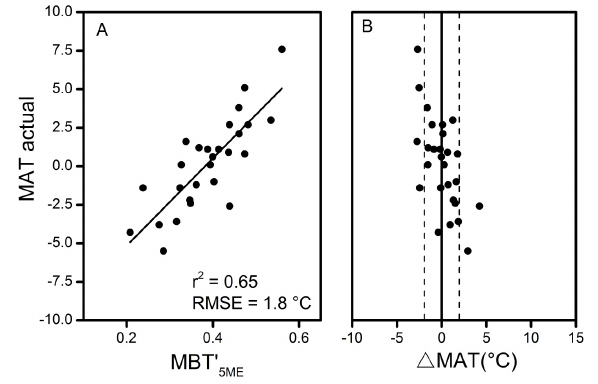
Figure 6. (a) Linear regression of MBT’ 5ME with actual MAT; (b) difference between estimated MAT and actual MAT ( (cid:49) MAT). Data in this study are from 27 surface soils of the QTP.